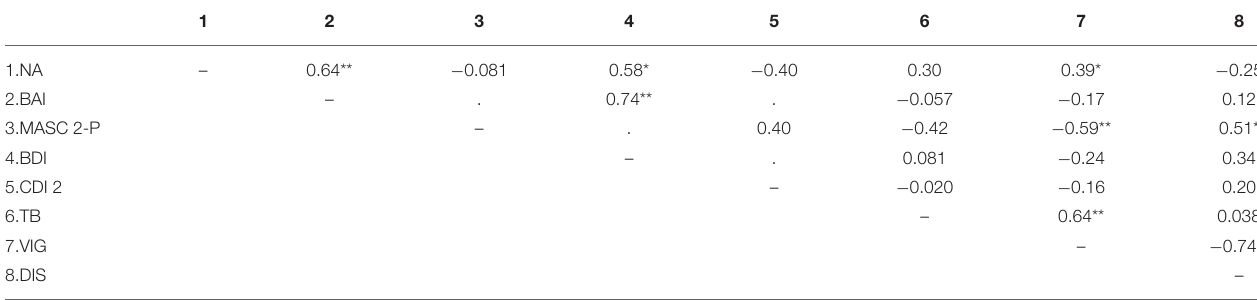
TABLE 4 | Correlations between the AB scores and symptoms at baseline.